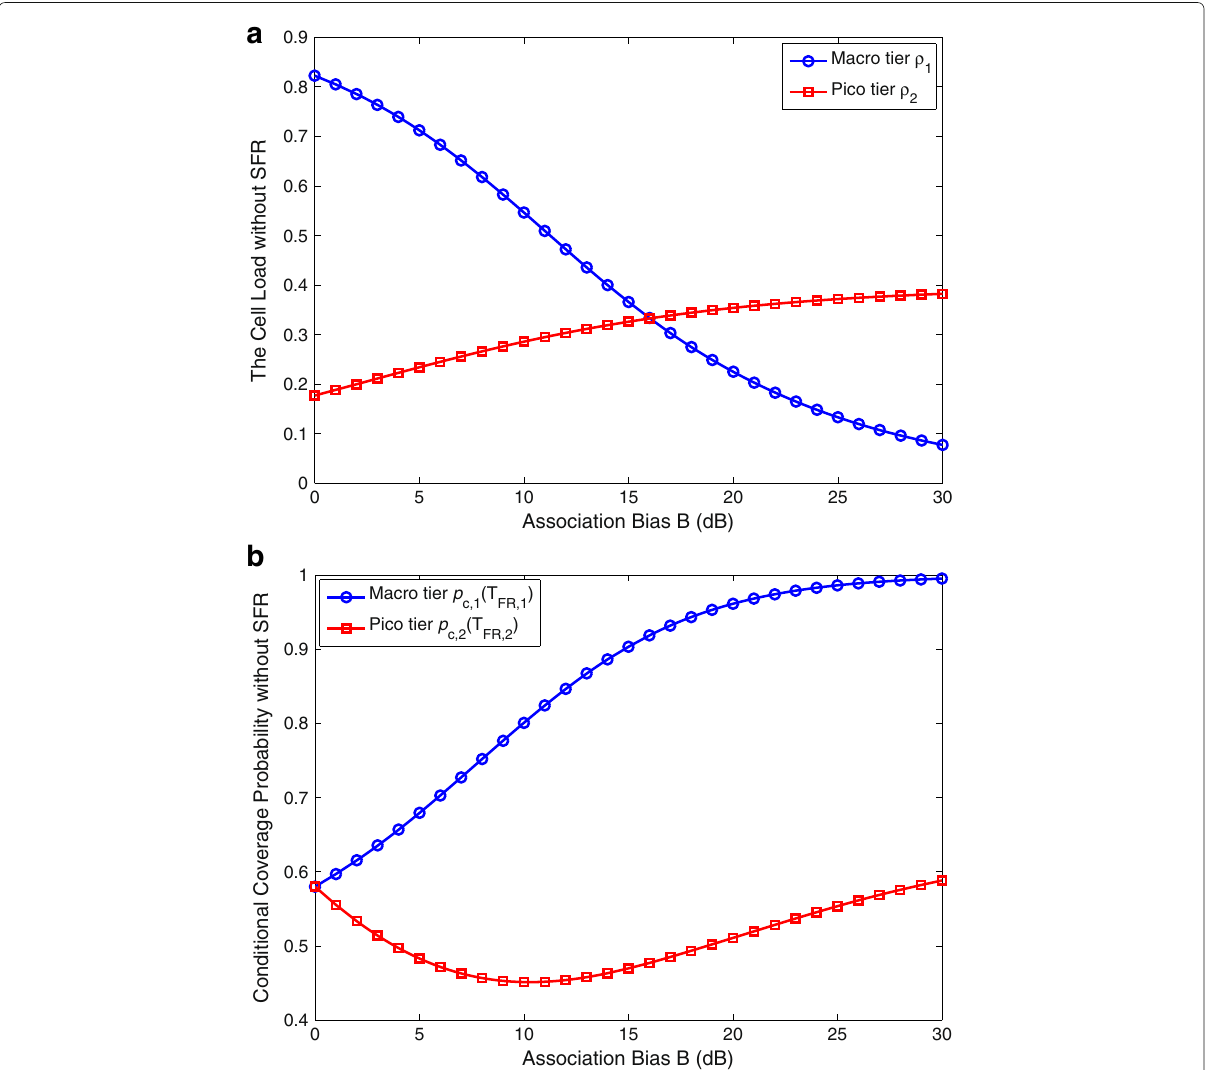
Fig. 4 Effect of the cell loads ρ 1 and ρ 2 on conditional coverage probabilities without SFR p c,1 (T FR,1 ) and p c,2 (T FR,2 ) for T FR,1 = T FR,2 = 3 dB